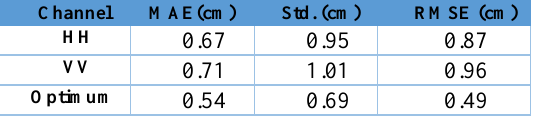
Table 2. Numerical comparison between HH/VV and optimum channel with GPS observations